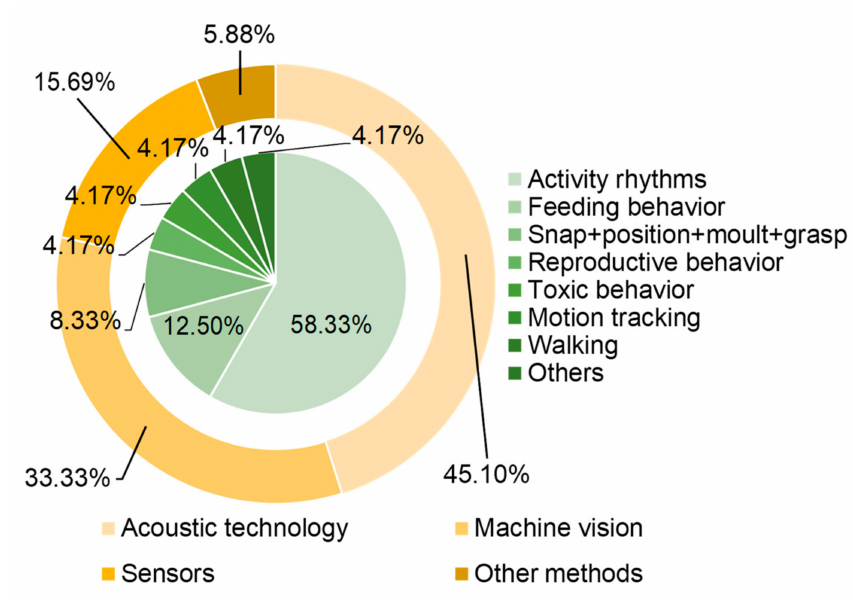
Figure 1. Number of papers with different methods and monitoring